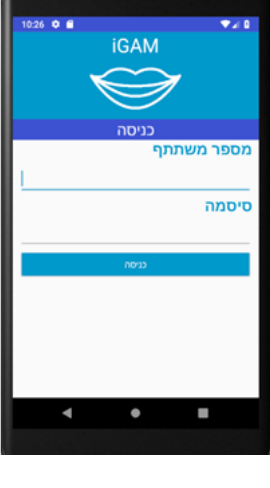
Figure 18. Login screen for the